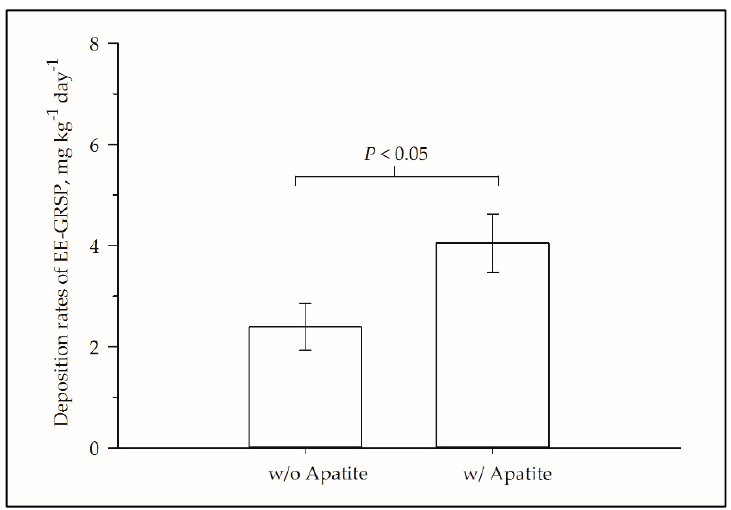
Figure 2. Easily extractable glomalin-related soil protein (EE-GRSP) deposition rates (per day) in sand bags. Two groups of sand bags were defined based on whether they contained (w/) or lacked (w/o) apatite. Error bars represent the standard error (SE) from the mean ( n = 10). Averages are significantly different at P < 0.05 level.